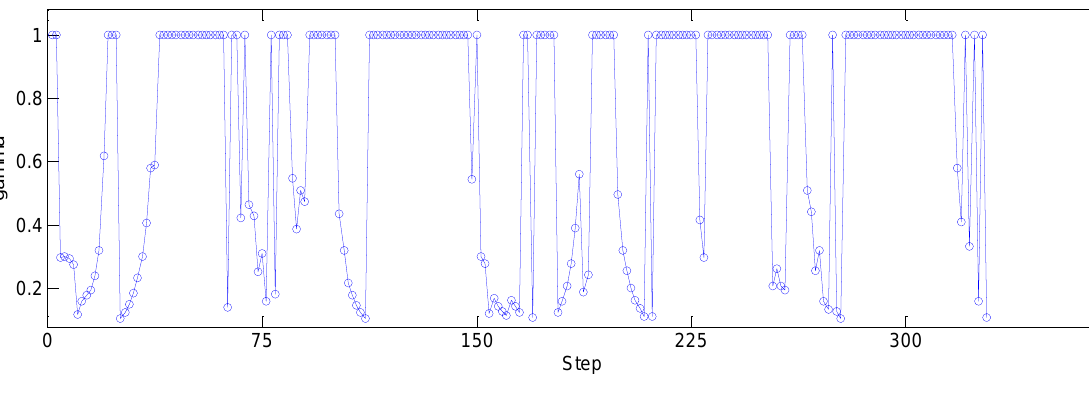
Figure 17. The variance of the adaptive parameter.